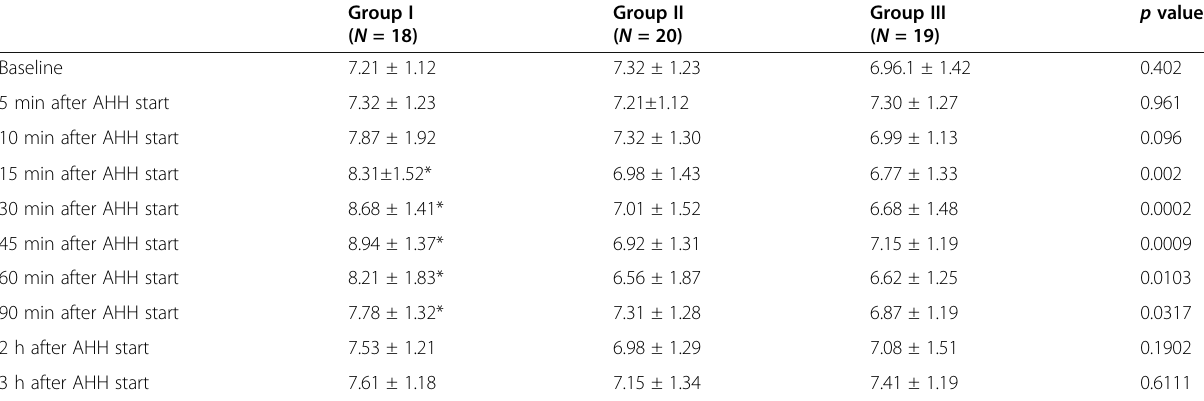
Table 4 Central venous pressure expressed in mmHg in the three study groups